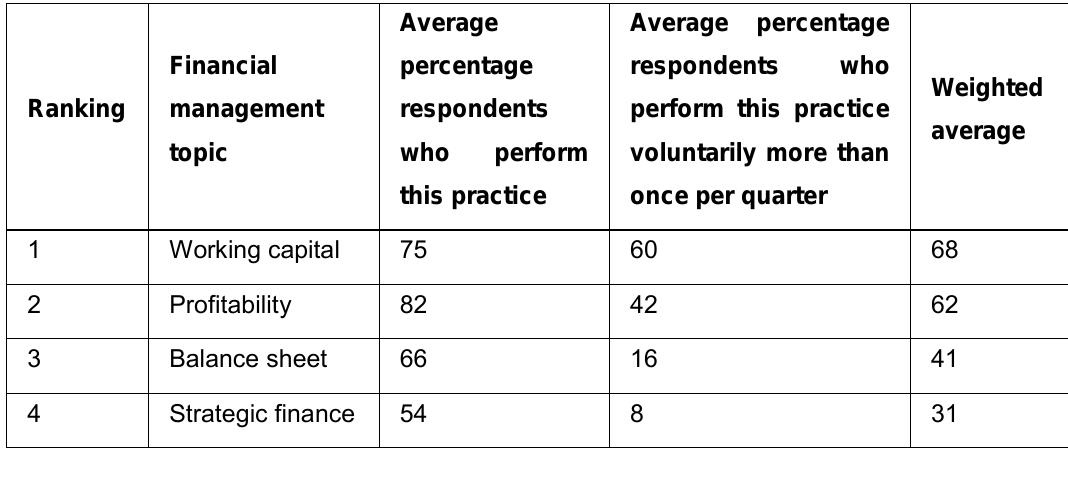
Ranking by financial management